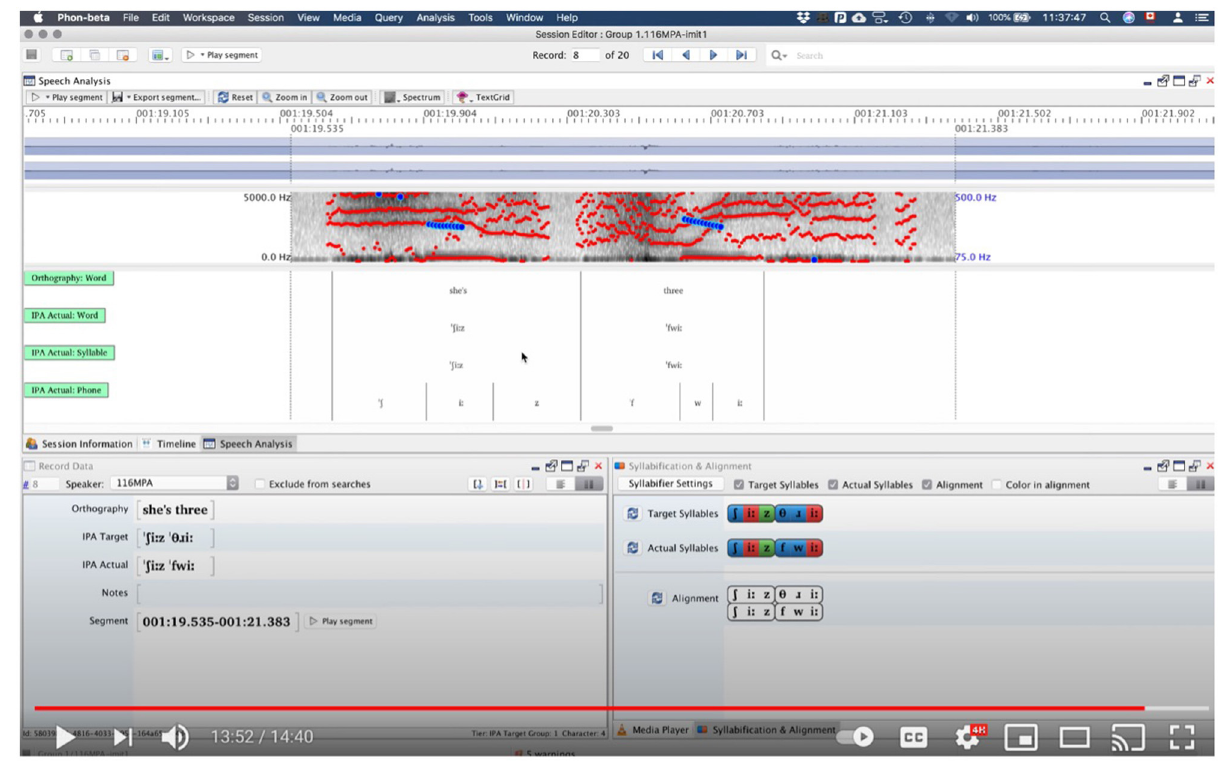
FIGURE 5 | Phon analysis of a child’s production of “she’s